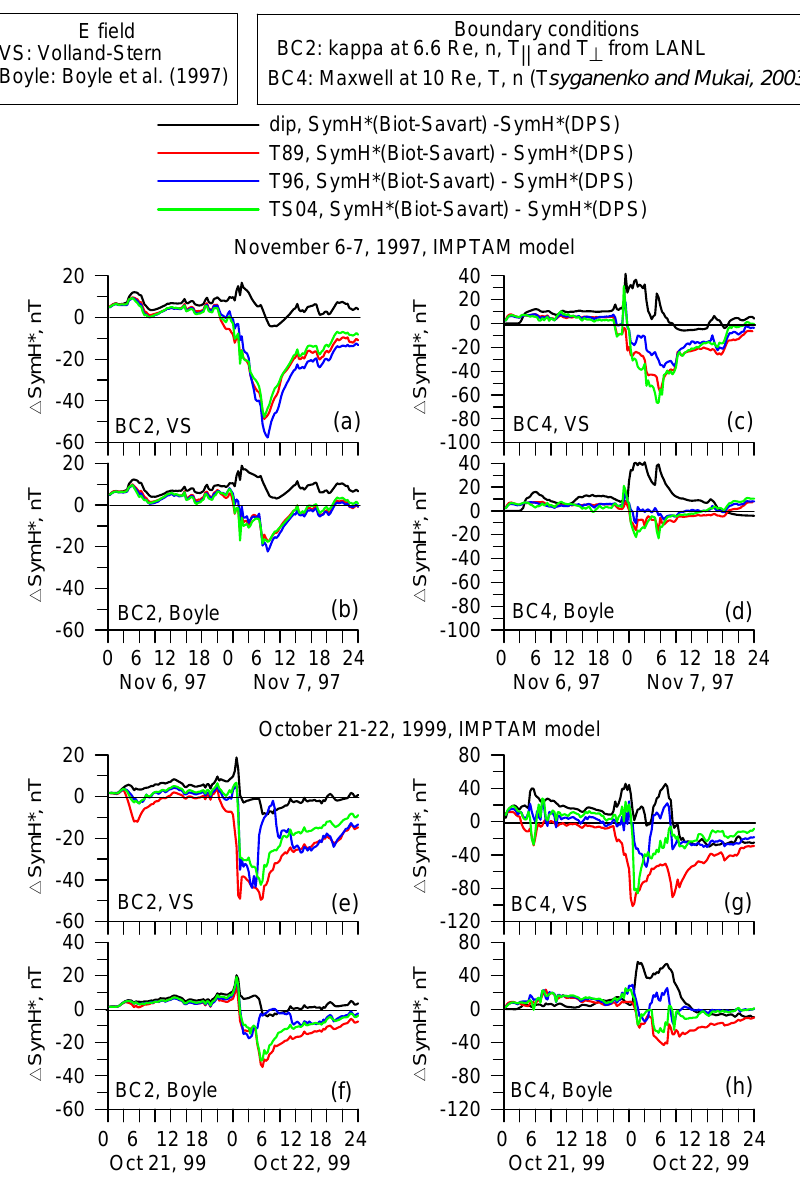
Fig. 16. Differences between model SymH* calculated by Biot-Savart’s law and DPS relation for moderate 6–7 November 1997 and intense 21–22 October 1999 storm